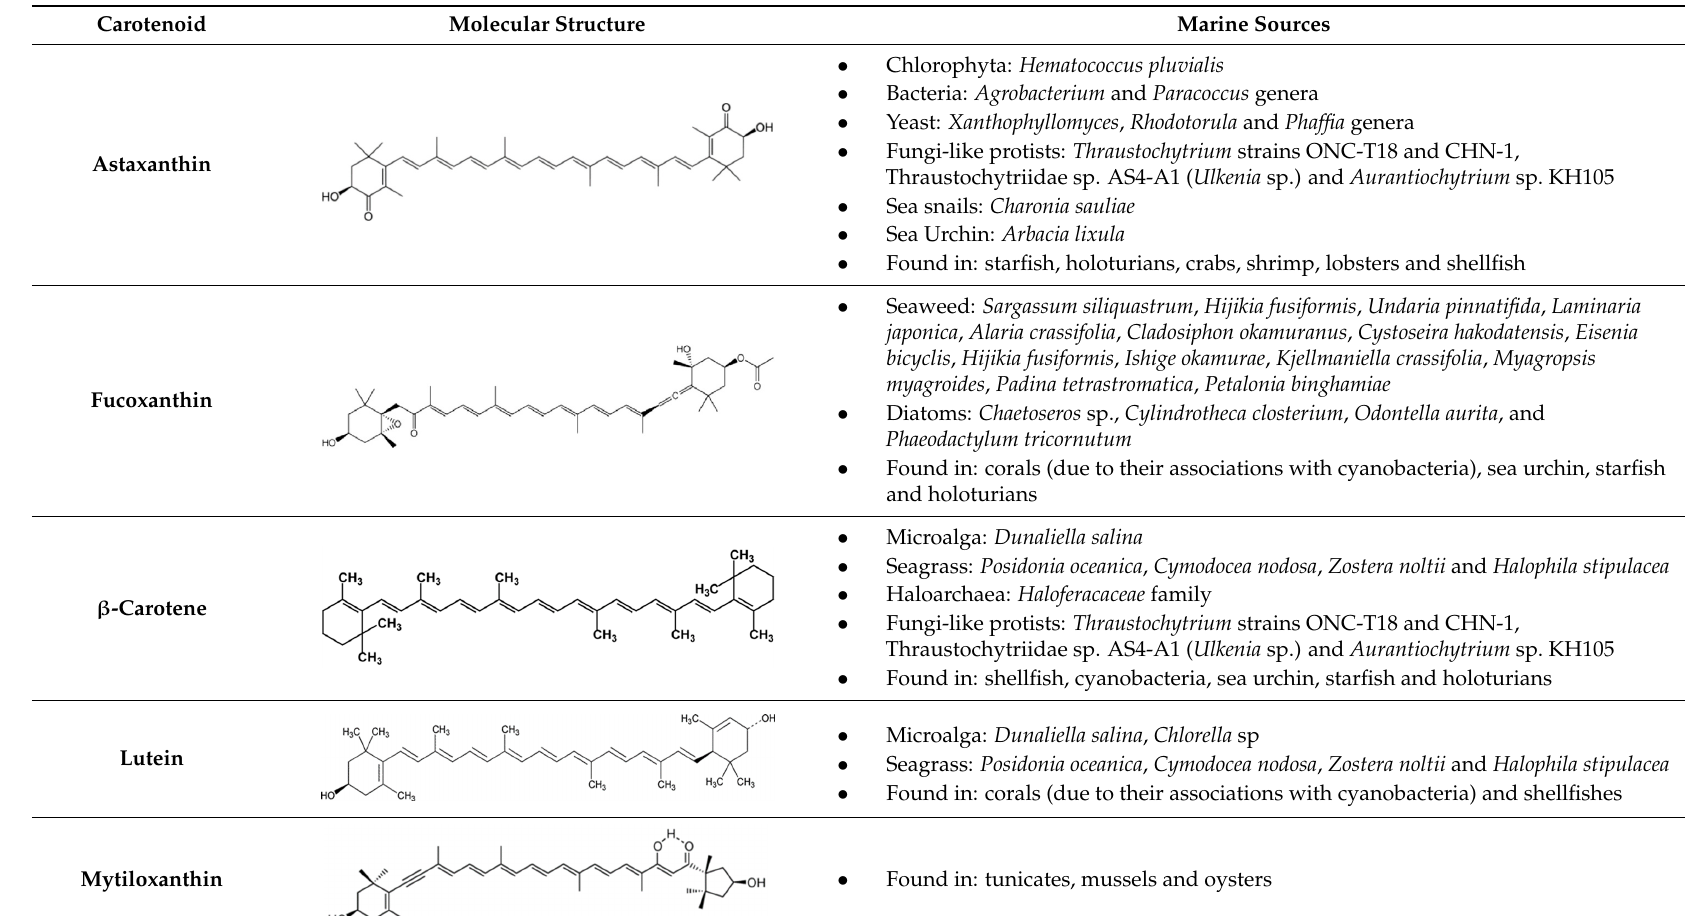
Table 2. Carotenoids from marine organisms and molecular structures.